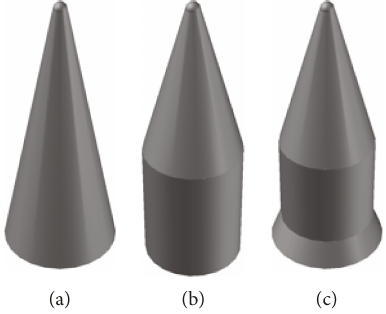
Figure 3: The structure model of space targets: (a) cone target; (b) cone-cylinder target; (c) cone-cylinder- fl are